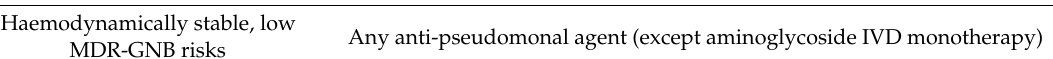
Table 2. The recommended regimens and dosage (if creatinine clearance rates ≥ 50 mL / min) for patients with hospital-acquired pneumonia of which aetiologies are likely related to Pseudomonas aeruginosa and / or methicillin-resistant Staphylococcus aureus. Clinical Severity and Risk Recommended Evaluation